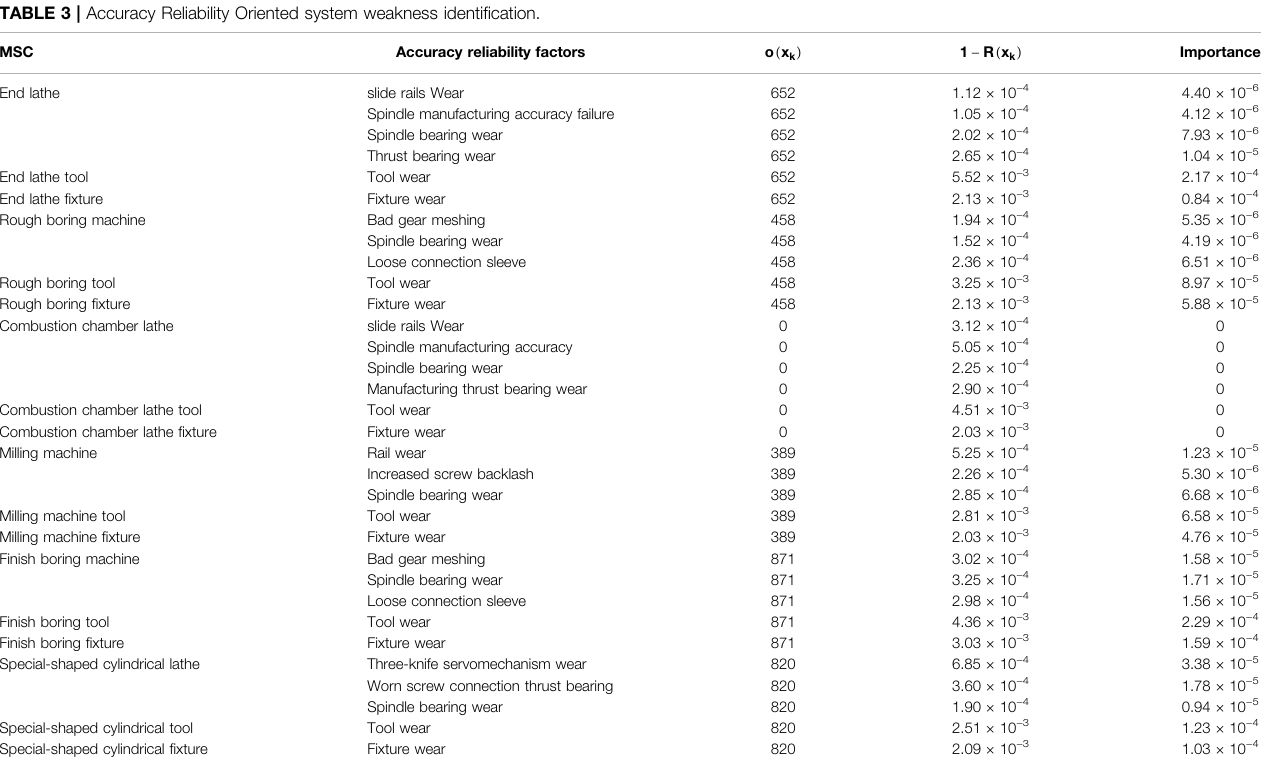
TABLE 3 | Accuracy Reliability Oriented system weakness identi fi